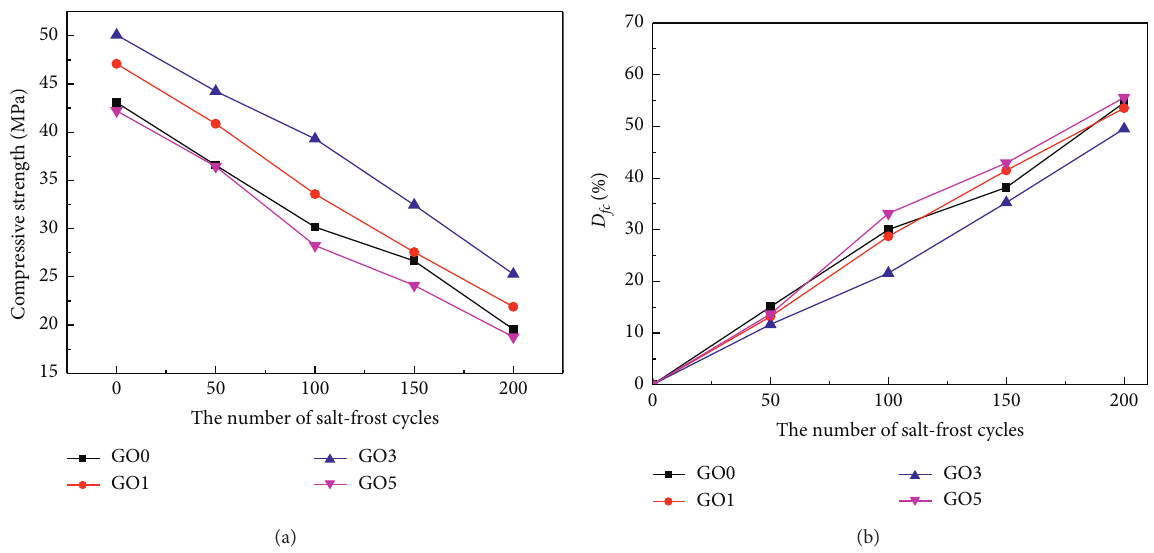
Figure 4: Relationship between the compressive strength of GO concrete and the number of salt-freezing cycles. (a) Relationship between salt-frost cycles and the compressive strength. (b) Relationship between salt-frost cycles and D fc .